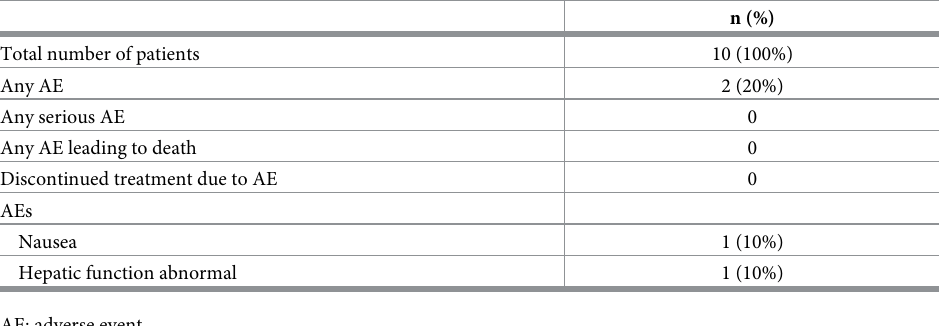
Table 3. Overview of the incidence of